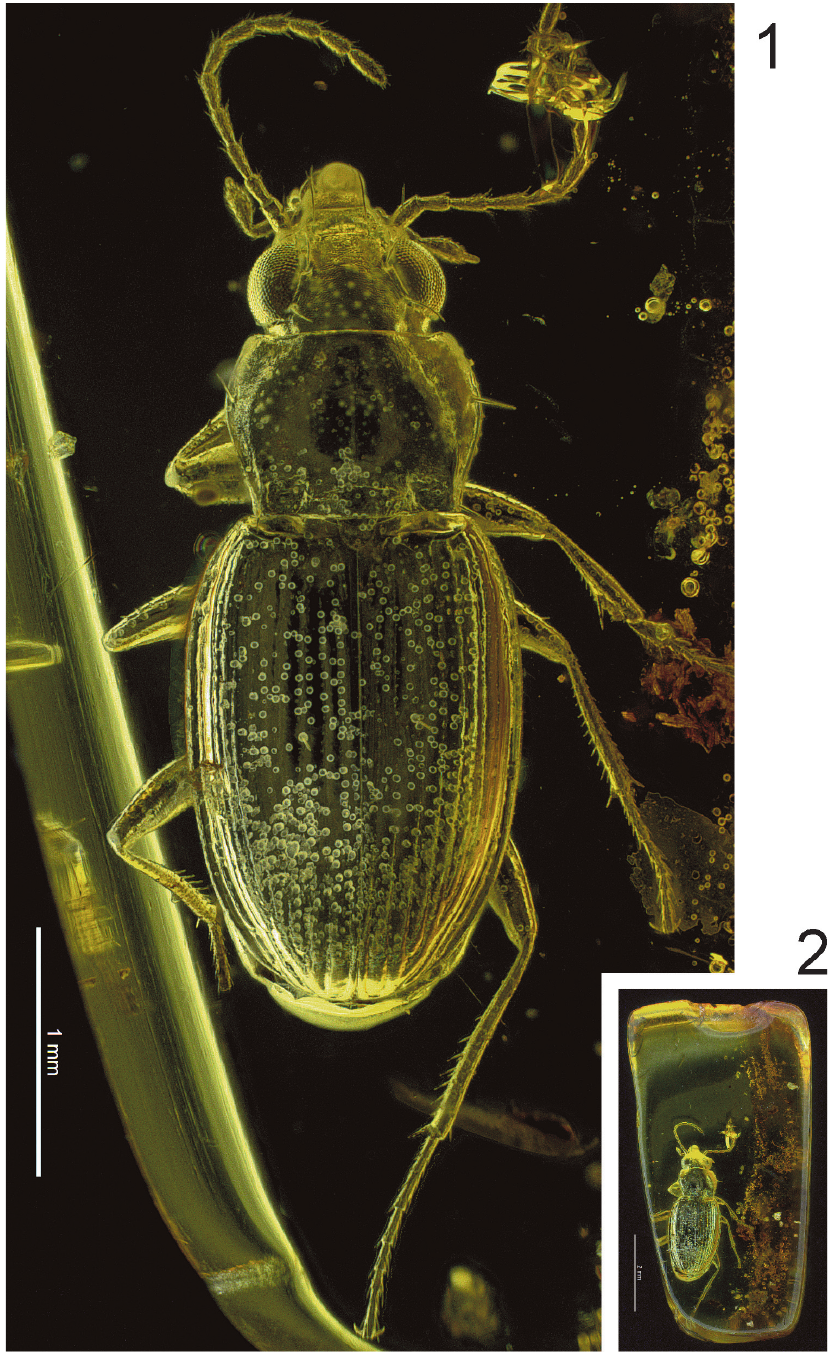
Figures 1–2. Bembidion bukejsi sp. n., light microscopic images of the holotype. 1 dorsal aspect 2 general view of the fossil with contours of the amber